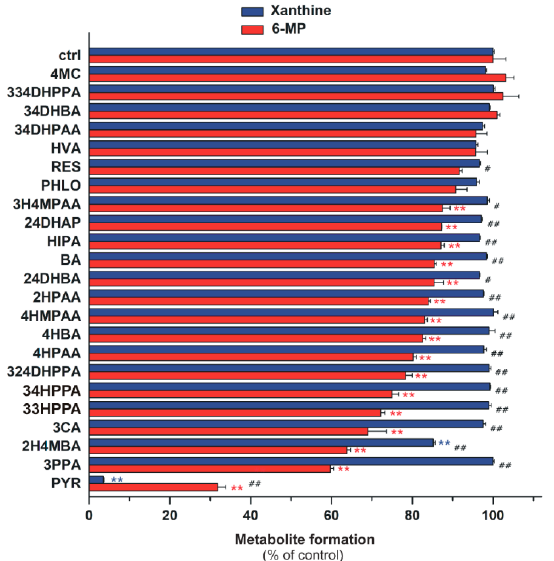
Figure 8. Effects of microbial flavonoid metabolites (each 20 μ M) on XO-catalyzed xanthine (5 μ M) and 6-MP (5 μ M) oxidation. The hash signs indicate significant differences (# p < 0.05, ## p < 0.01) between xanthine and 6-MP oxidation. Whereas the asterisks mark significant decreases (* p < 0.05, ** p < 0.01) in xanthine or 6-MP oxidation, as compared to that of control.